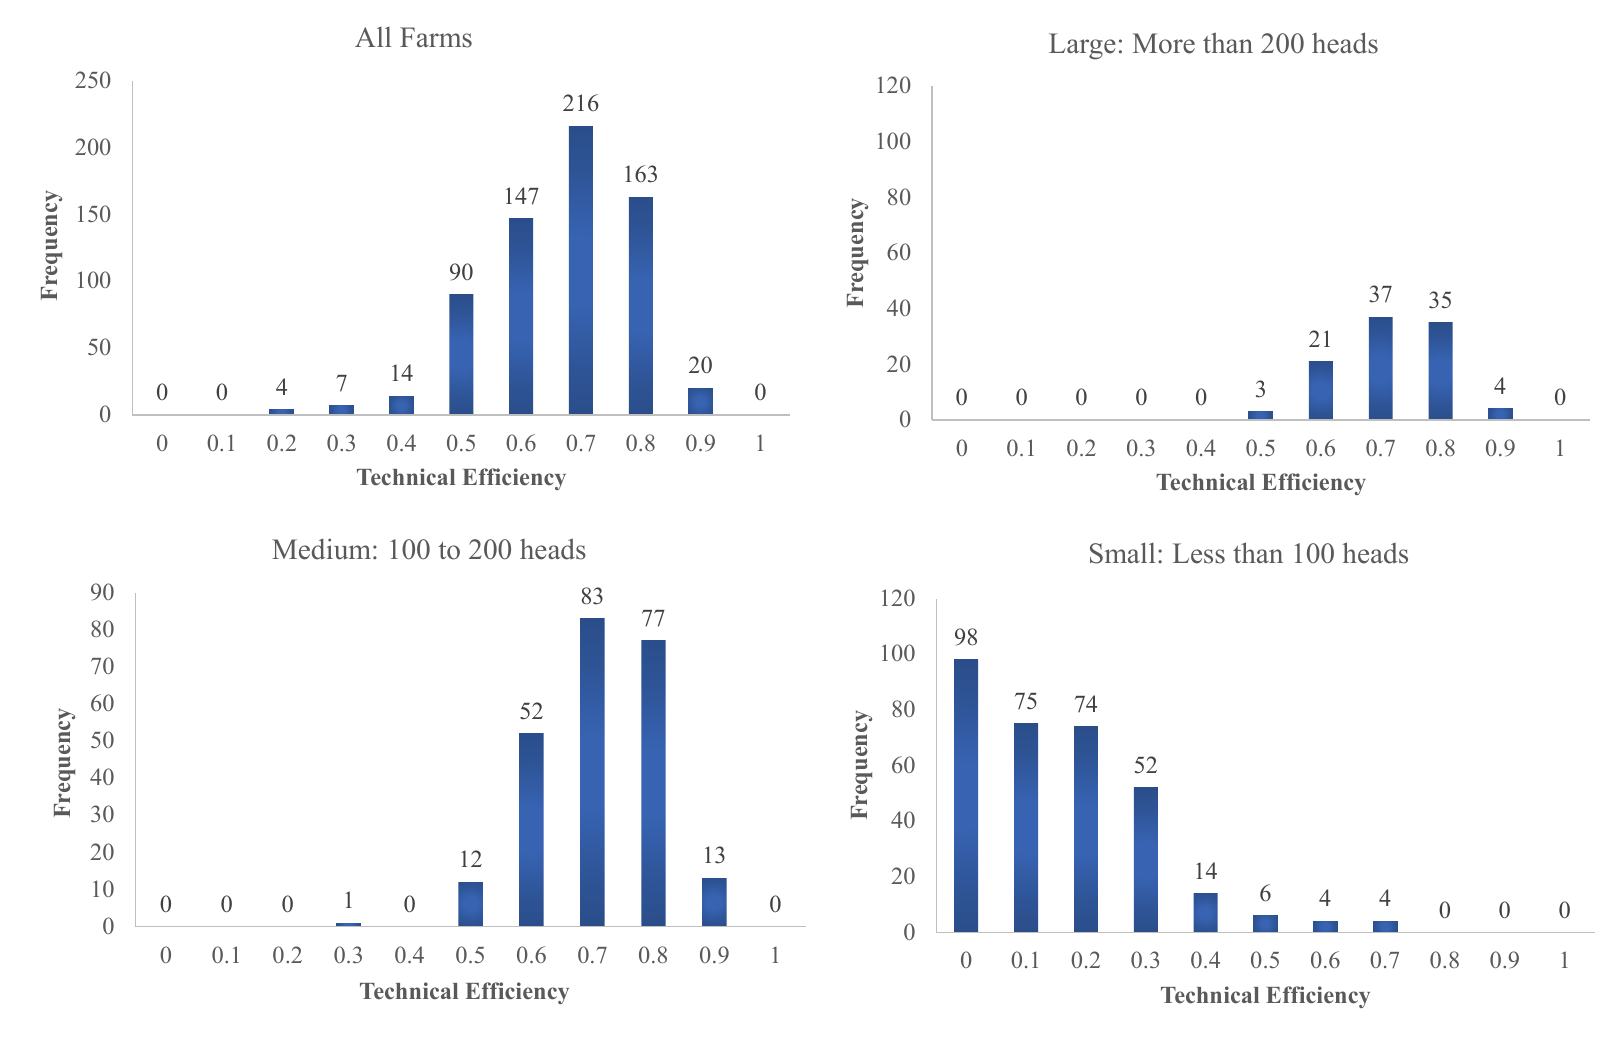
Figure 2. Sheep technical efficiency